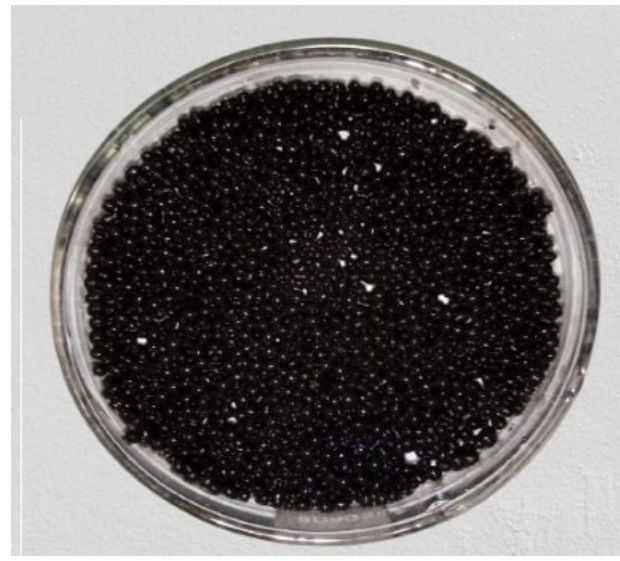
Figure 1. Images of Met-GO/SA polymer nanocomposite hydrogel beads.